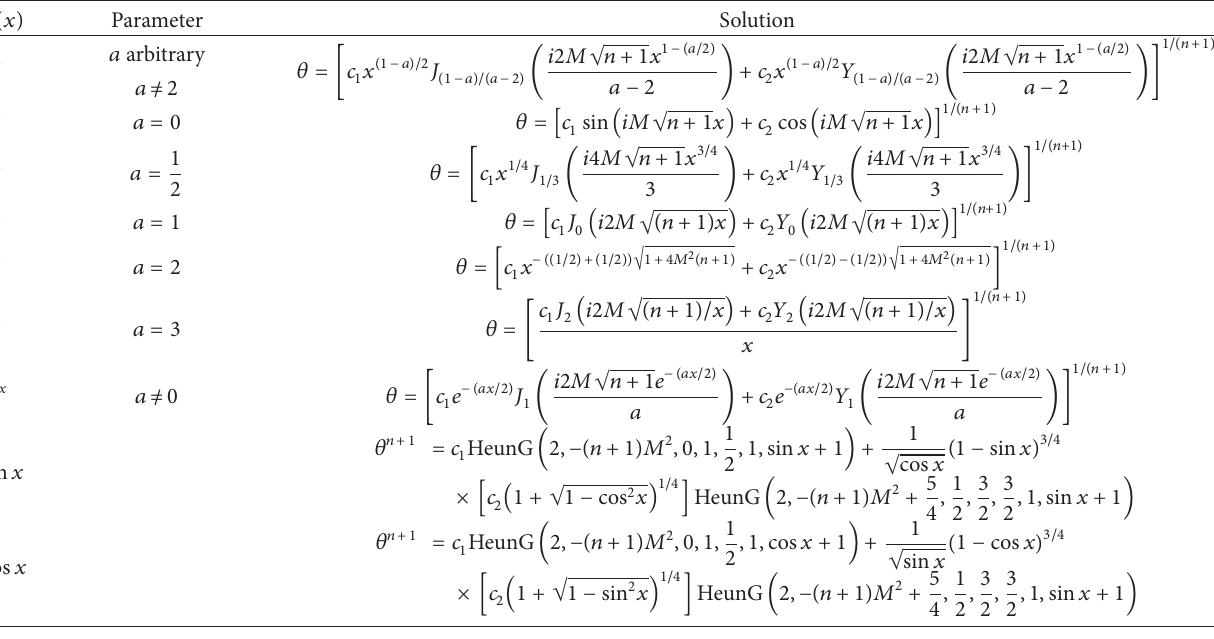
Table 1: Solution for 𝑛 > −1 with 𝑚 = 𝑛 ̸= − 1 .